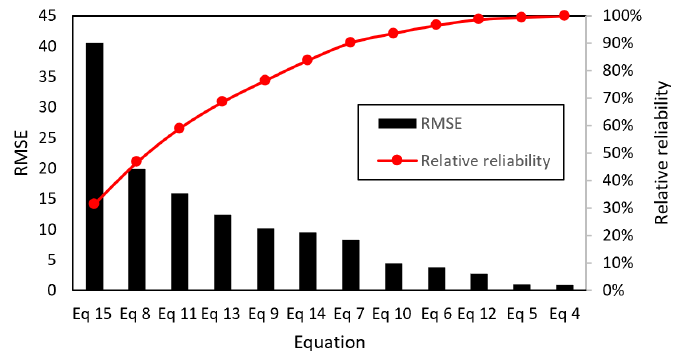
Figure 20. Normalized comparison between compressive strength prediction equations based on UPV.